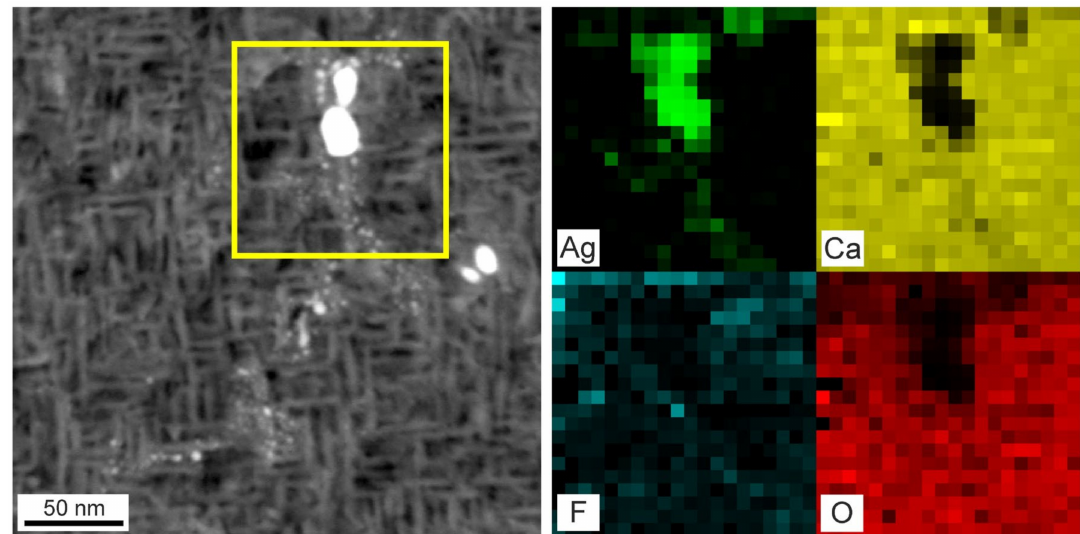
Figure 6. STEM (lefthand side)/EDX (righthand side) results showing the elemental composition analysis of Ag NPs in the CaF 2 matrix. The yellow box frames the EDX analyzed